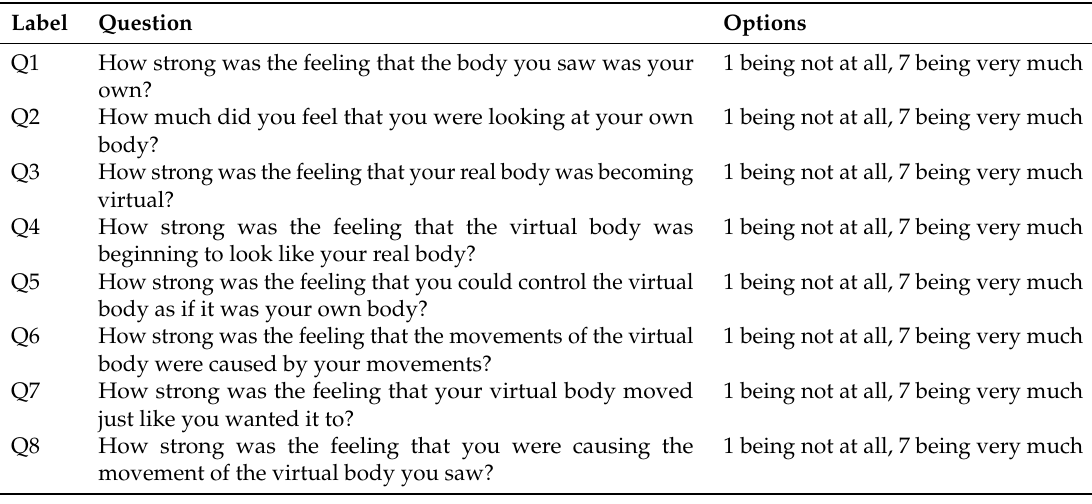
Table 2. The questionnaire used during the